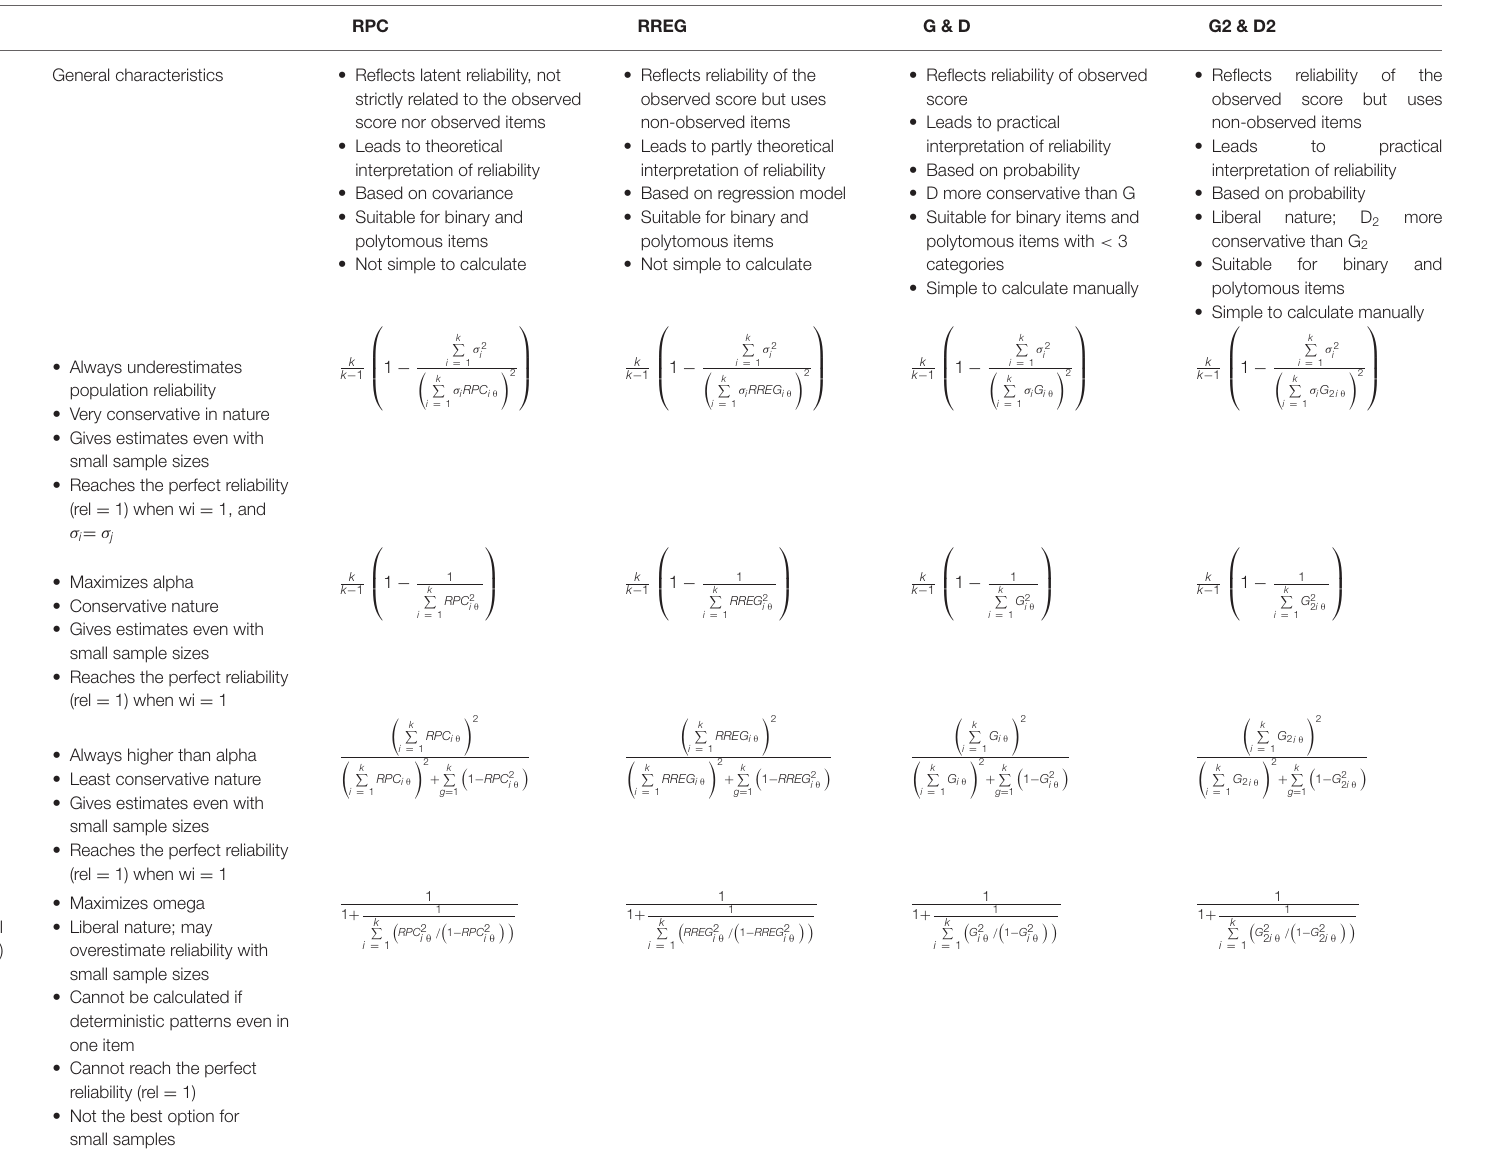
TABLE 2a | Typology of selected deflation-corrected estimators of reliability and their